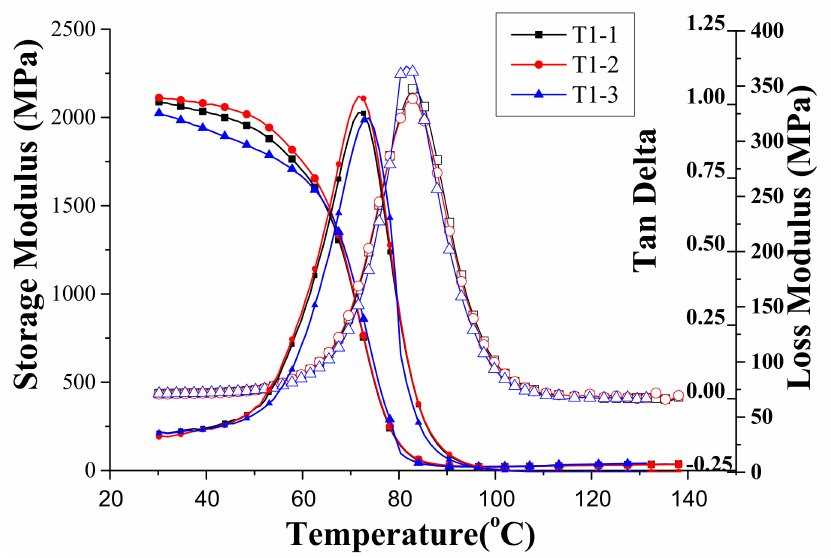
Figure 4. The dynamic properties of Specimen T1 measured with the temperature sweeping from 30 ◦ C to 140 ◦ C.